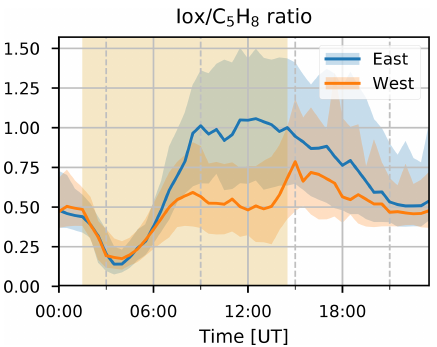
Figure 8. Median diel profile of ratio between isoprene oxidation products (Iox) and isoprene (C 5 H 8 ), separated according to the wind direction observed at the Maïdo observatory: blue and orange for winds coming from the east and west, respectively. Interquartile ranges for each direction are shown as shaded areas in the back- ground with colors corresponding to the curve. The shaded yellow area in the back corresponds to median daylight period over the 2- year observation period.